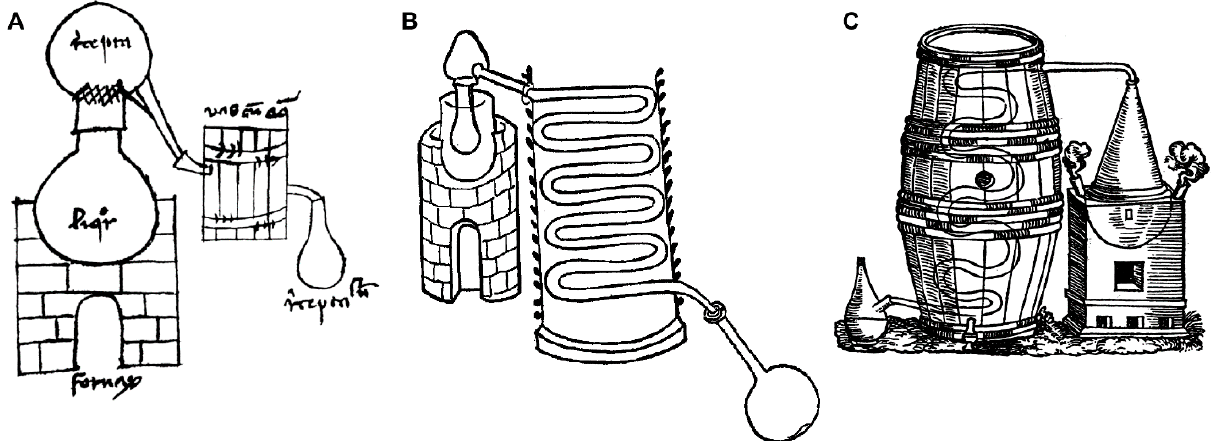
Figure 3. External cooling trough as depicted in the treatise of Johann Wenod (A) and illustrations of the worm-like nature of the “worm- cooler” cooling coil from: (a) Philipp Ulstadt’s Coelum Philosophorum seu De Secretis Naturae Liber, 1525 (B) and Walter Ryff’s Neu Gross Destillierbuch , 1556 (C).